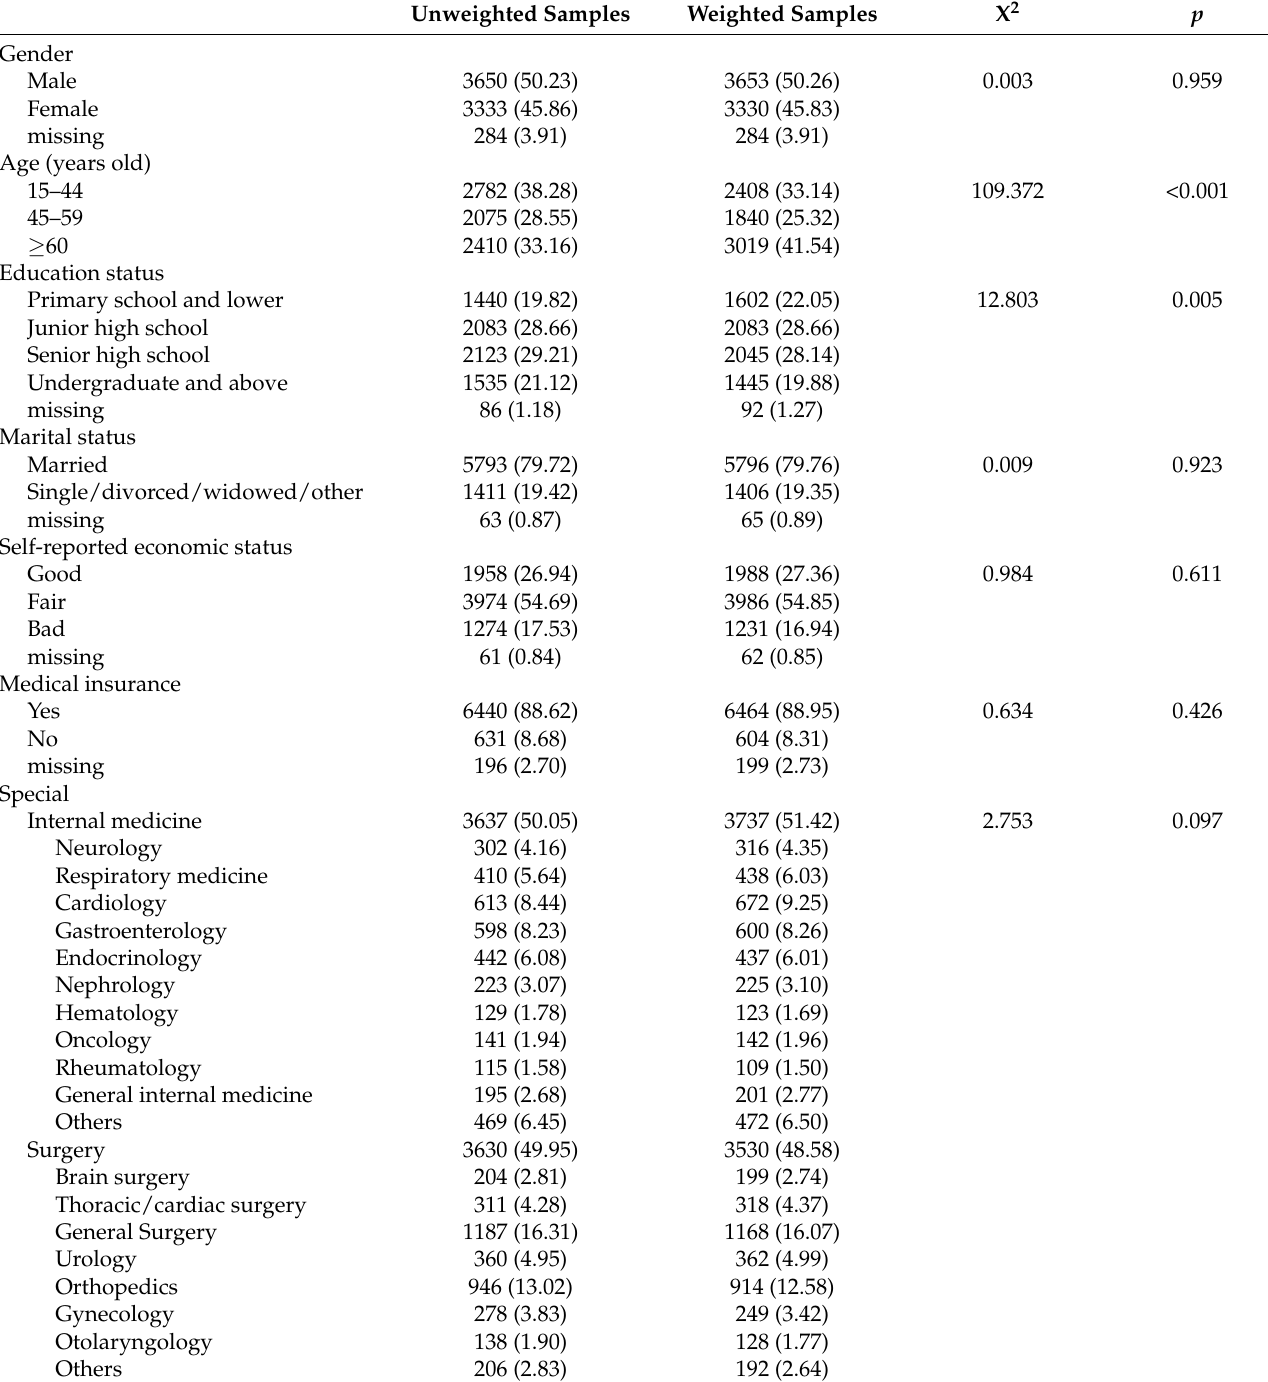
Table 1. Socio-demographic characteristics of participants. Unweighted Samples Weighted